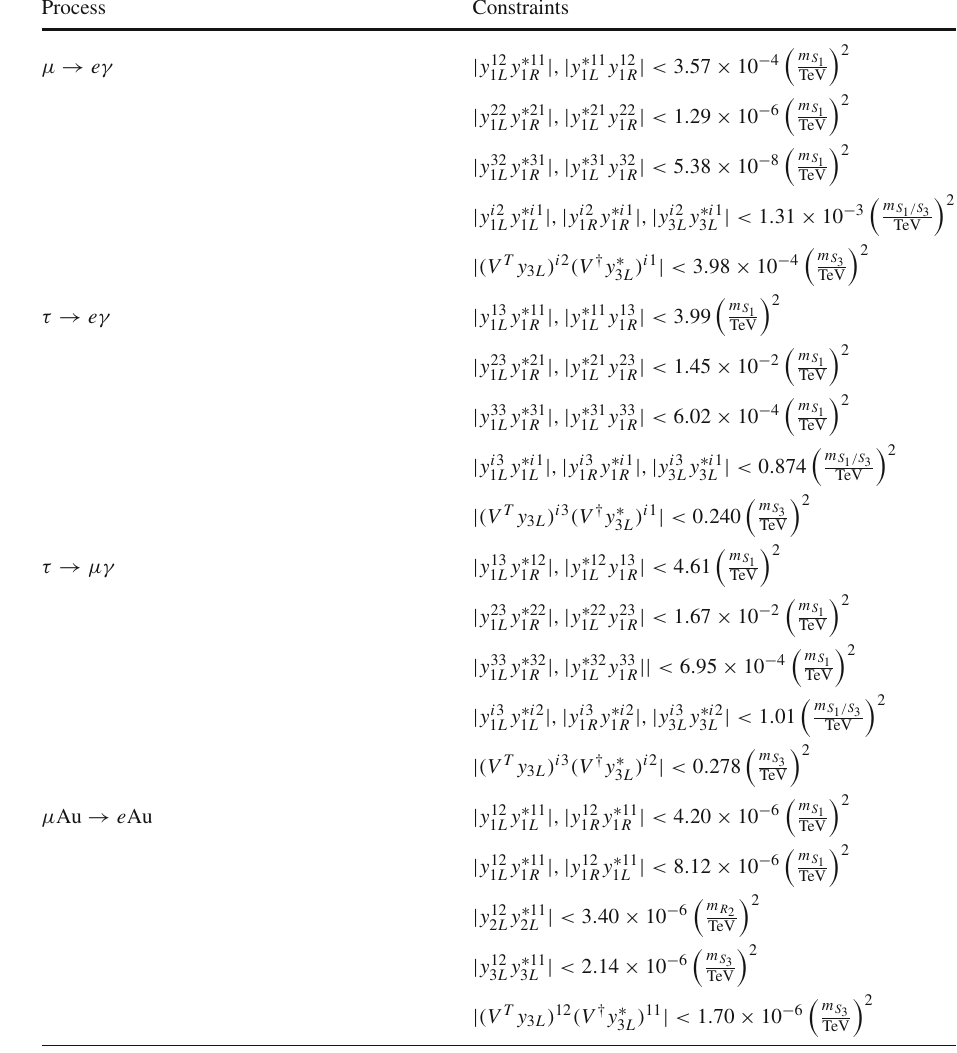
Table 2 Upper limits on the leptoquark couplings from the processes (cid:15) → (cid:15) (cid:6) γ and μ Au → e Au